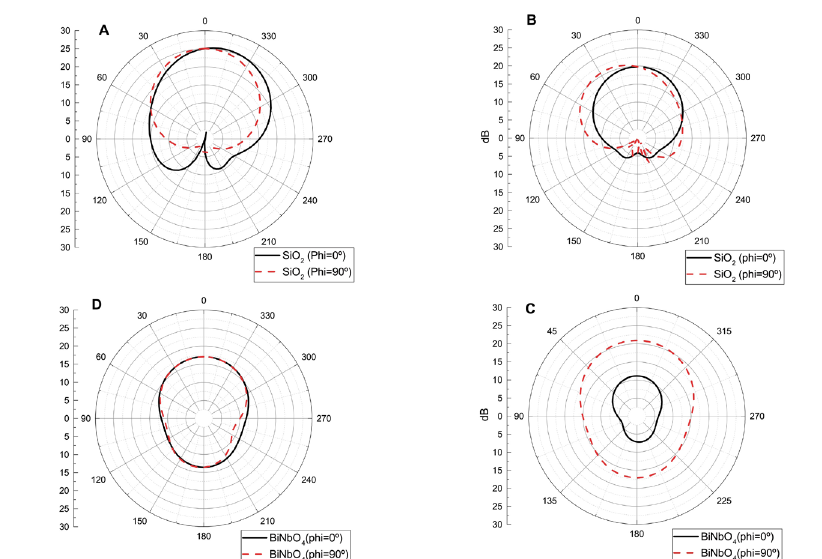
Figure 3. (a) shows the resistance of the antennas, in black and in blue the SiO and BiNbO antennas, respectively, simulated in 2 4 CST and HFSS. (b) shows the reactance of the antennas, in black and in blue the SiO and BiNbO antennas, respectively, simulated 2 4 in CST and